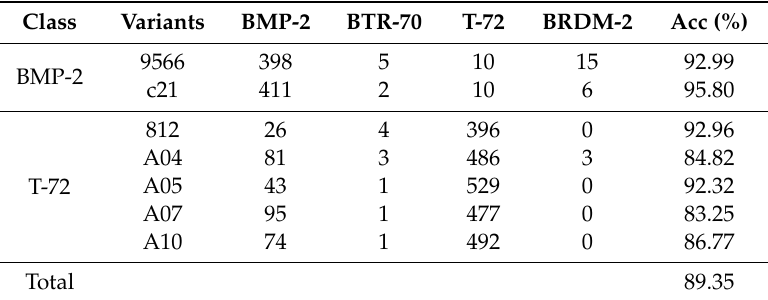
Table 12. Confusion matrix of ESENet under EOC2 (configuration